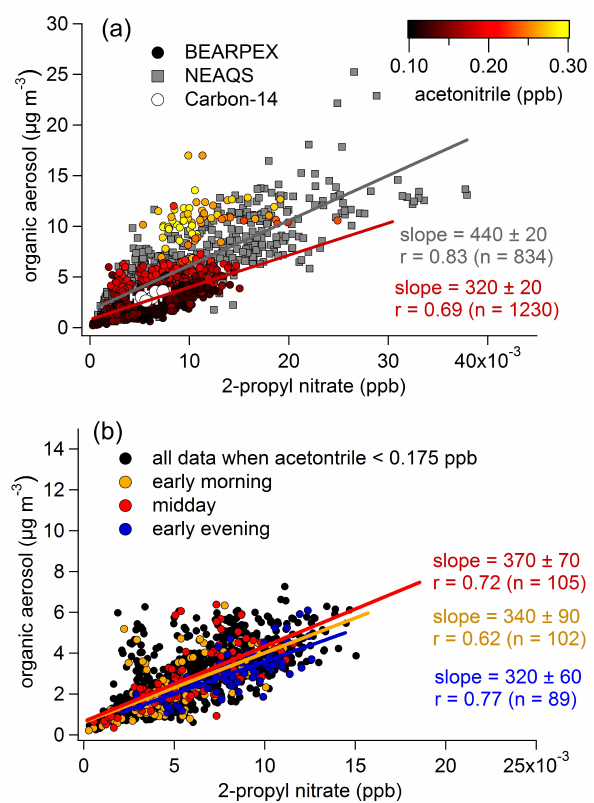
Fig. 2. (a) Scatter plot of organic aerosol (OA) versus 2-propyl ni- trate for BEARPEX (this work; black circles) and the New England air quality study (NEAQS (de Gouw et al., 2005); grey squares). The radiogenic carbon ( 14 C) data is shown as filled white squares and the BEARPEX data is color coded by acetonitrile to show that the 14C sampling period was not influenced by biomass burning. (b) Scatter plot of OA vs. 2-propyl nitrate filtered by acetonitrile ( < 0.2ppb) and separated into three time periods; early morning (07:00–09:00; orange circles), midday (12:00–14:00; red circles) and early evening (19:00–21:00; blue circles).